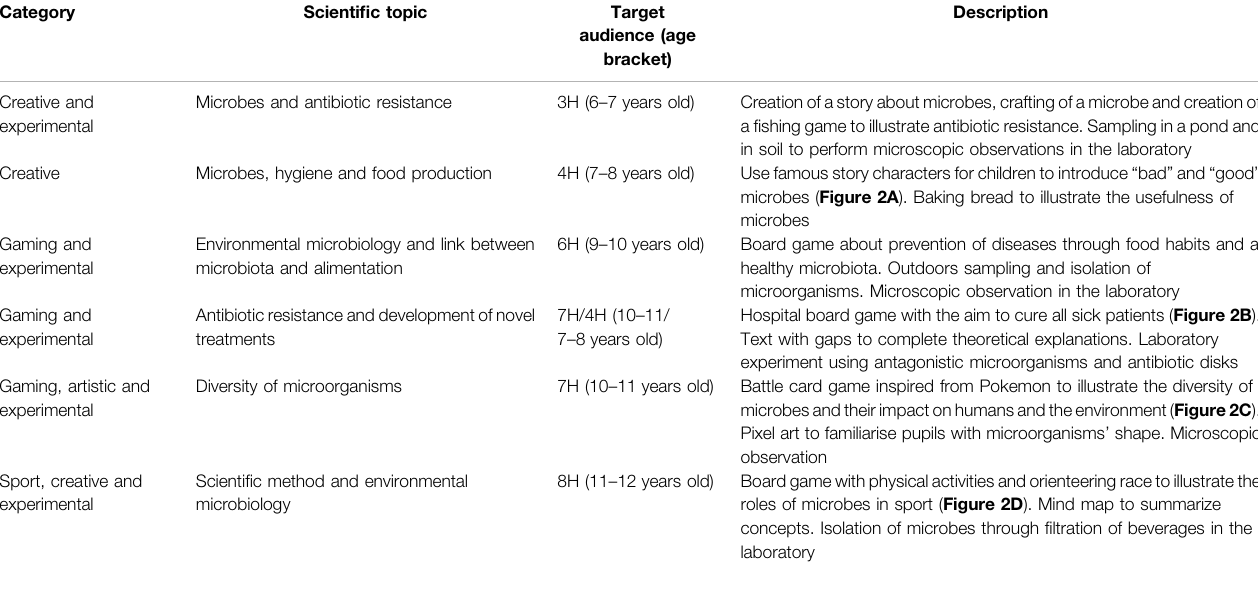
TABLE 2 | Service-learning activities proposed in 2021. For each activity, the category, scienti fi c topic, target audience (standard school level according to harmonized -HarmoS- educational level de fi ned by the « Conférence suisse des directeurs cantonaux de l ’ instruction publique (CDIP) »), and a brief description of the activity are provided.